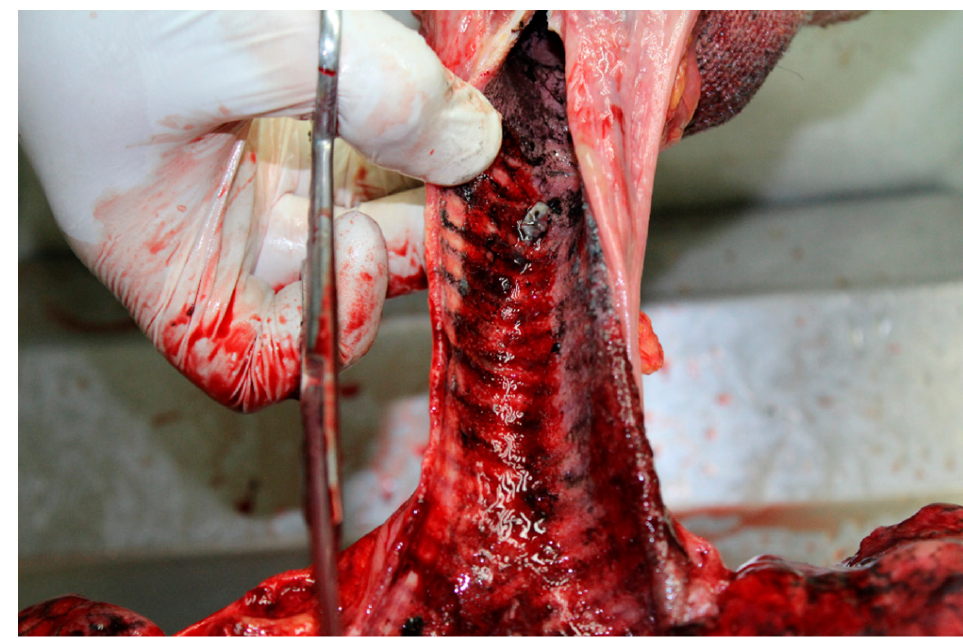
Figure 2. Trachea and the openings to the main bronchi after dorsal dissection: The presence of deposited soot.